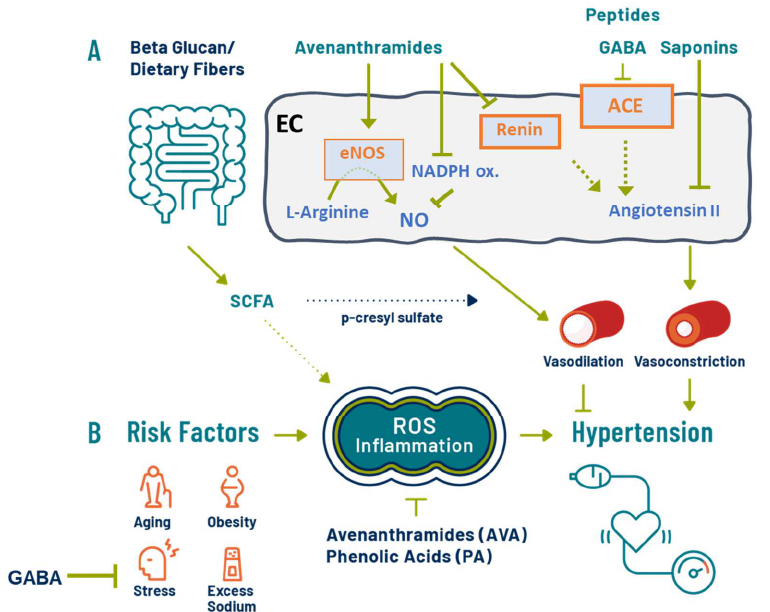
Figure 1. Mechanism of action of the anti-hypertensive effects of oat bioactives. ( A ) Gut microbiome- mediated metabolism of oat dietary fibers can increase circulating short-chain fatty acids (SCFA) involved in the reduction of hypertension, in part via reduction of p -cresyl sulfate, associated with vascular function (vasodilation) and cellular oxidative damage. In the endothelial cells (EC), av- enanthramides (AVA) and phenolic acids (PA) induce vasodilation and enhance vascular function by endothelial nitric oxide (NO) synthase (eNOS) and by inhibiting NADPH oxidases’ regulation of NO degradation. Furthermore, angiotensin II-mediated vasoconstriction, endothelial dysfunction, and hypertension can be directly inhibited by oat saponins or indirectly by AVA inhibition of renin and GABA inhibition of angiotensin-converting enzyme (ACE) upstream of angiotensin II. GABA, AVA, and oat saponin can help improve endothelial cell function. ( B ) Risk factors can elicit a pathological rise of systemic inflammation and elevated intracellular levels of reactive oxygen species (ROS) that are critically implicated in the etiology of hypertension. Oats’ PA and AVA are anti-inflammatory and antioxidant bioactives that could contribute to the maintenance of a healthy